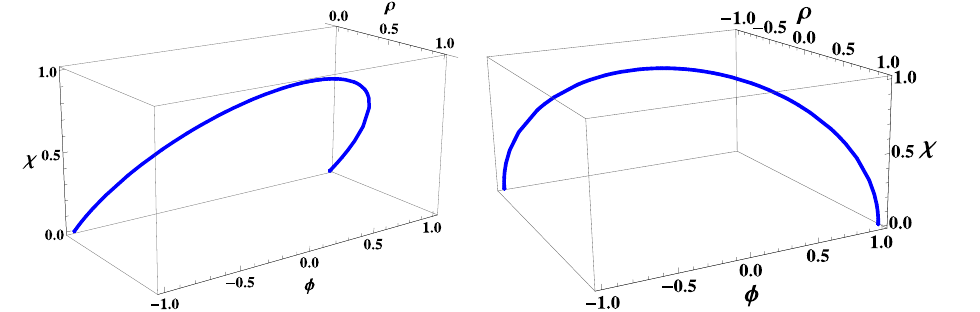
Fig. 1 Parametric graphics for the analytical orbits approached in examples I (left panel), I I (right panel), all plotted with a = b = 1